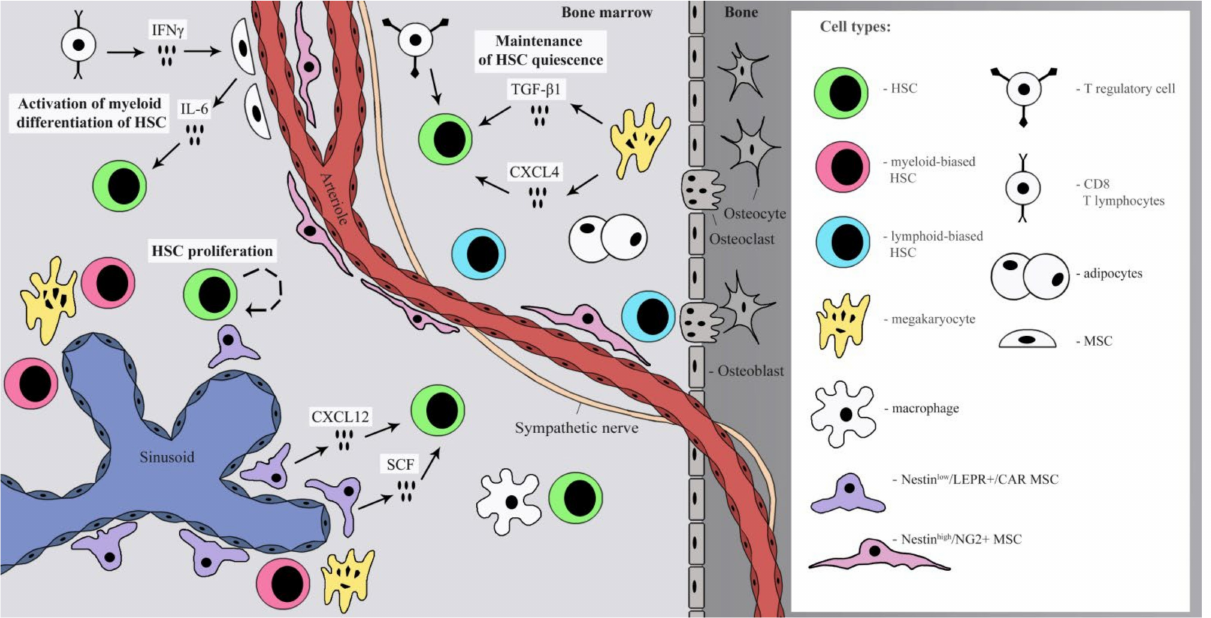
Figure 1. Cellular and selected molecular components of the HSC niche in BM. The reader is referred to the Section 3 for more detailed information on properties and roles of specific niche cell